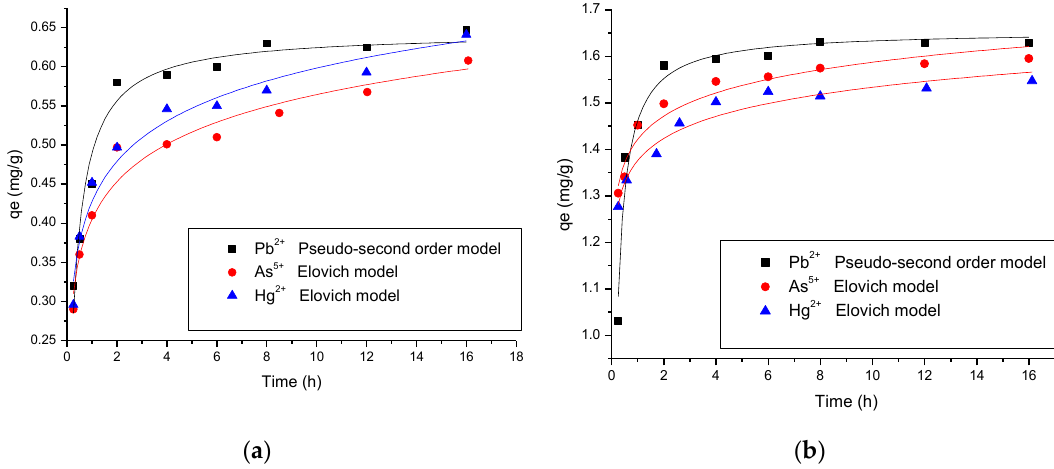
Figure 3. Kinetic of (a) Eggshell and the (b) nanocomposite for Pb, As, and Hg removal (The symbols represent experimental data while lines are the best-fit mathematical model according to R 2 ). Table 1. Values of the characteristic parameters of kinetics models and correlation coefficients for Pb 2+ As 5+ and Hg 2+ .